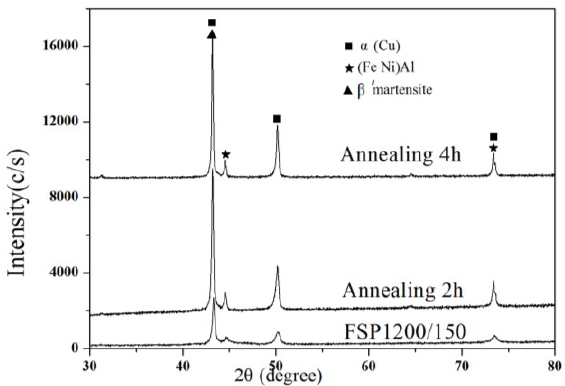
Figure 4. The X-ray diffraction patterns of FSP NAB and post heat treated